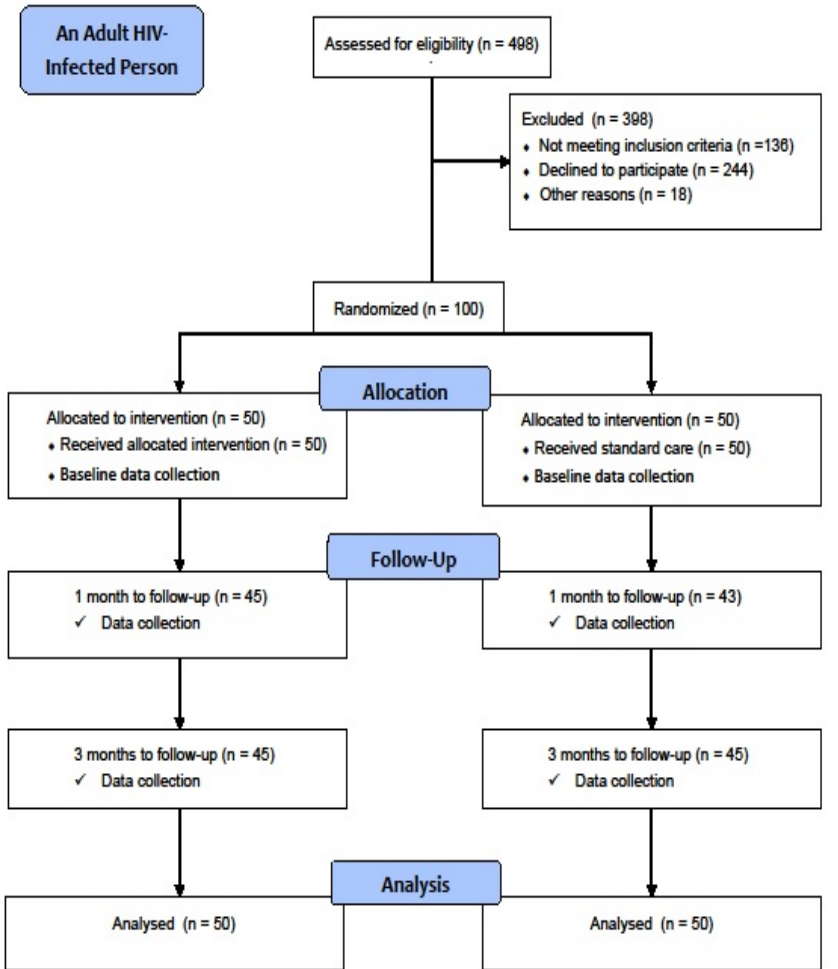
Figure 1. Flow chart diagram of the study using CONSORT statement [17].